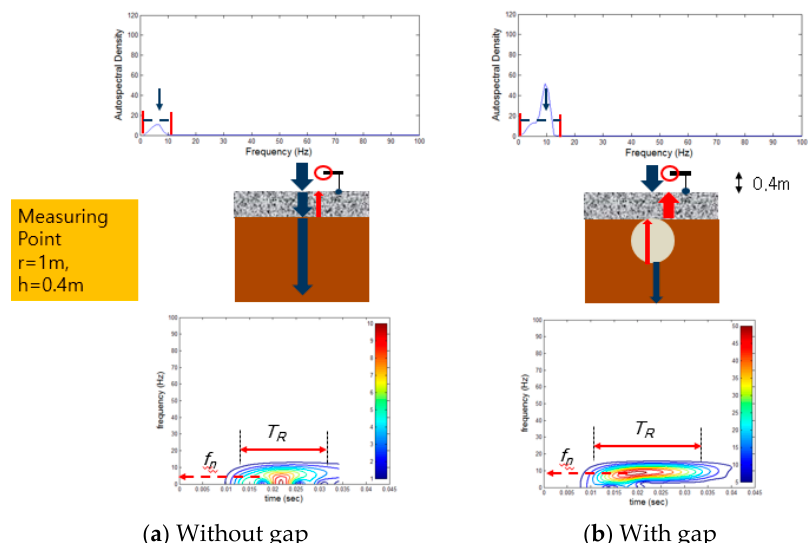
Figure 11. Leaky Rayleigh acoustic waves detected in the air transmitted from the concrete surface. ( a ) Without gap. ( b ) With gap.